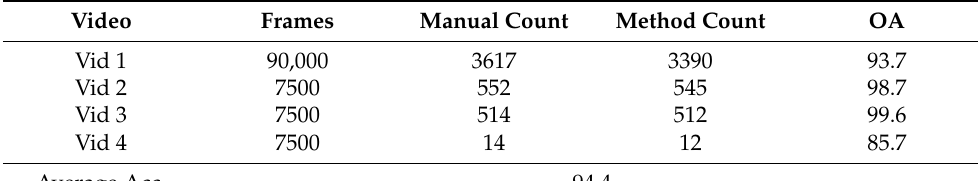
Table 6. Results of the count on different qualities of videos using YOLOv5l. Video